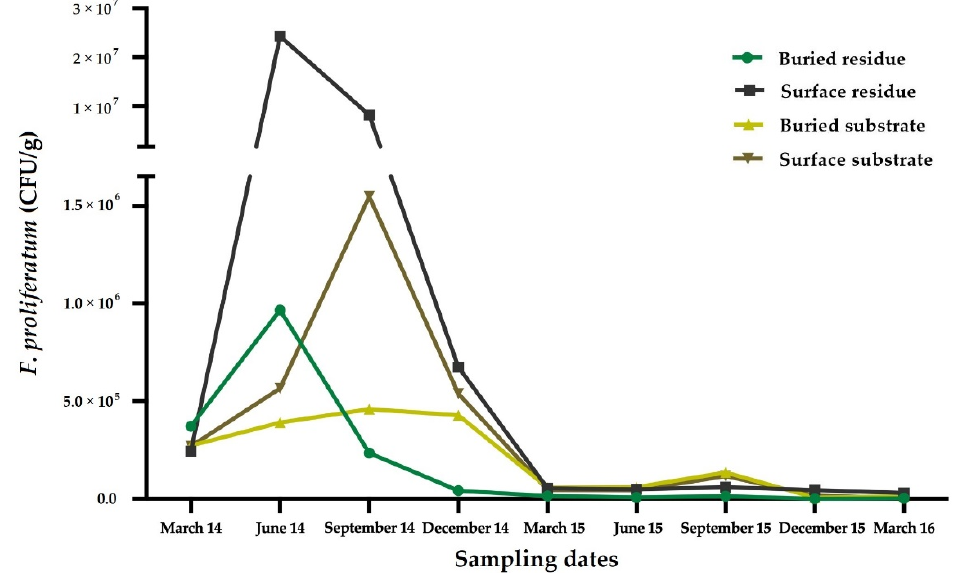
Figure 5. Time course of the Fusarium proliferatum inoculum in the soil and in the garlic residue as a function of depth (surface or buried) under natural field conditions. Data are expressed as mean colony forming units per gram (CFU/g). Gálvez [114].